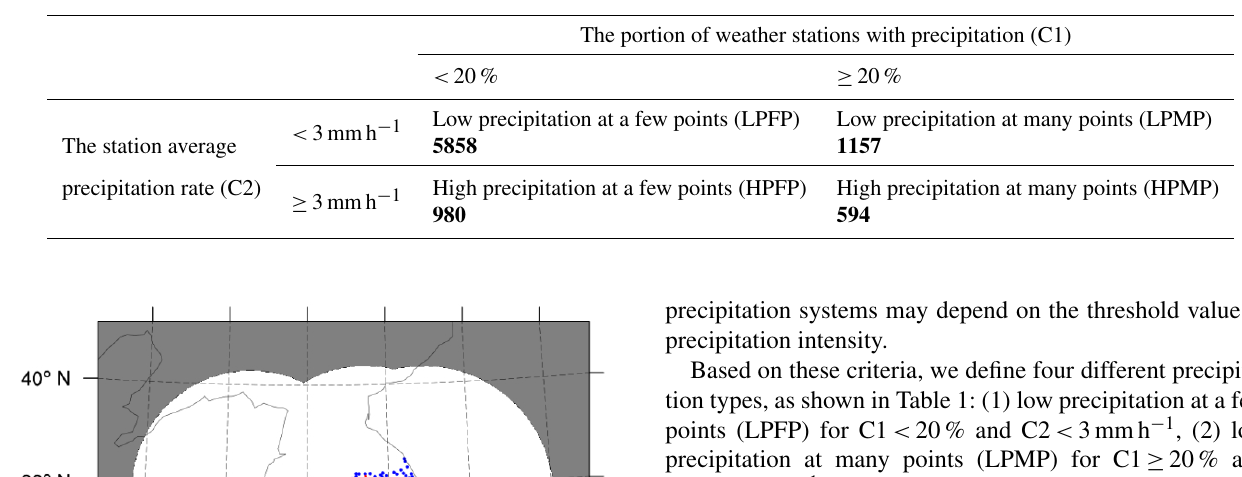
Table 1. Classification of precipitation types with the number of events (in bold).